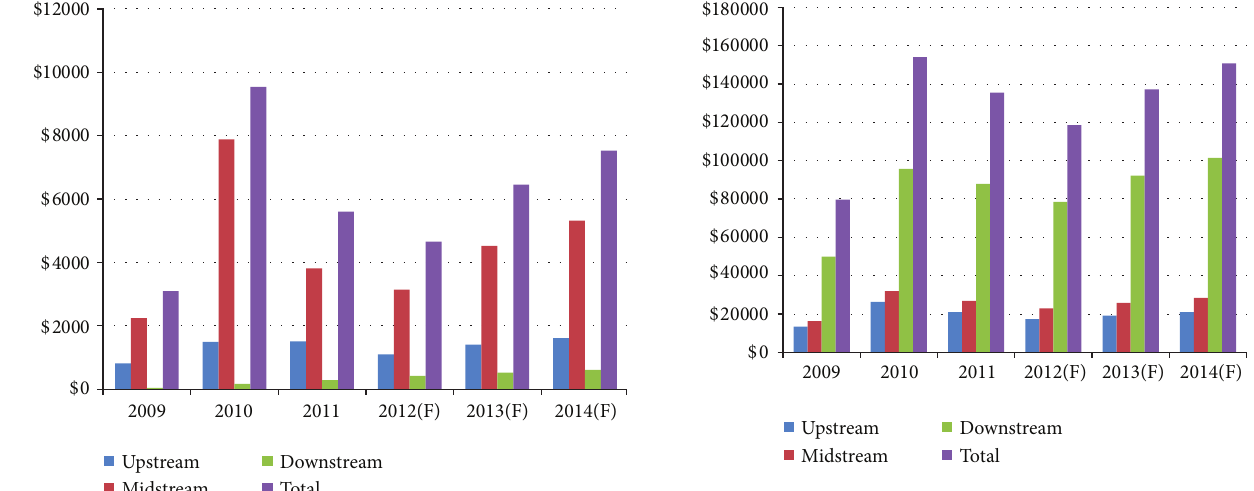
Figure 2: Revenue of global solar photovoltaic industry. Upstream: silicon material; Midstream: solar cell (wafer-based); Downstream: solar cell module and solar photovoltaic system. Source: adapted from PIDA (2012)